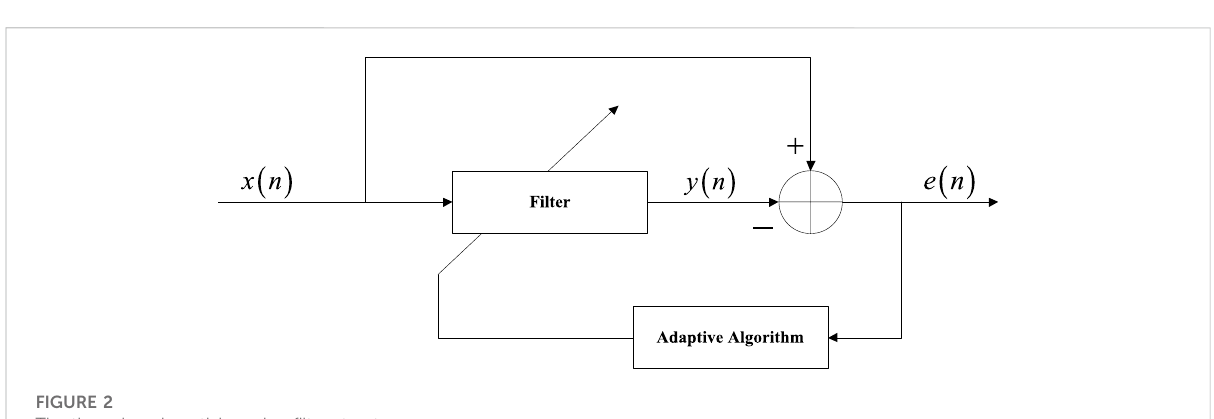
FIGURE 2 The time-domain anti-jamming fi lter